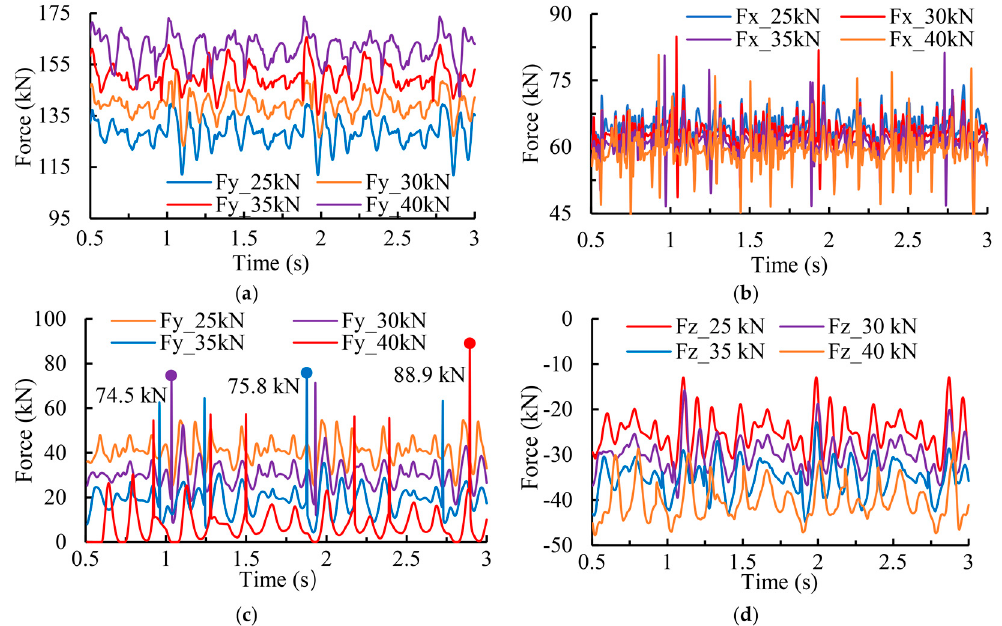
Figure 5. Mechanical property of the traction unit under di ff erent lateral force: ( a ) The y-direction force of the walking wheel; ( b ) The x-direction force of the walking wheel; ( c ) The y-direction force of the support slipper; and ( d ) The z-direction force of the guide slipper.